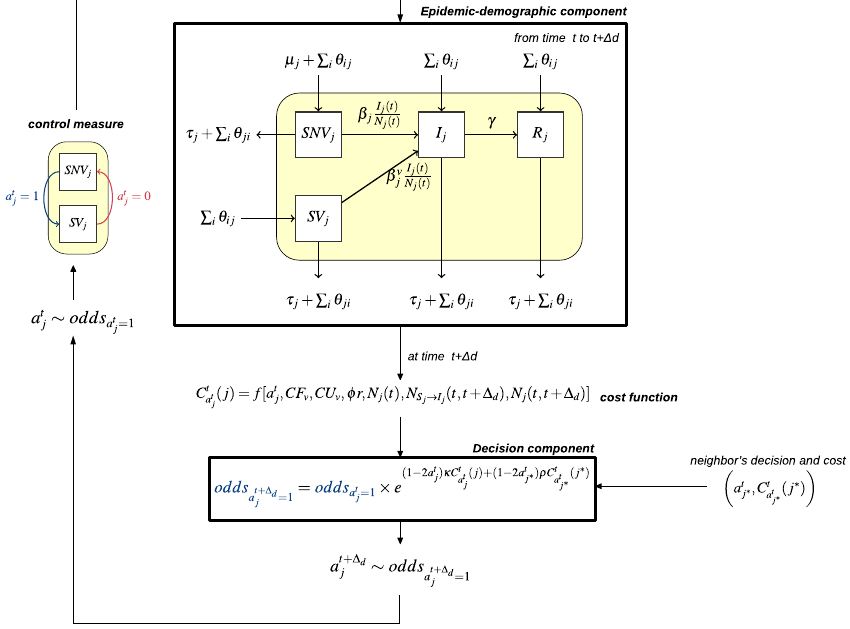
Figure 2. Representation of the integrative epidemic-decision dynamical model for a herd j , accounting for vaccinating decisions with a protective effect ( β v j < β j ). See main text in “Methods” for parameter